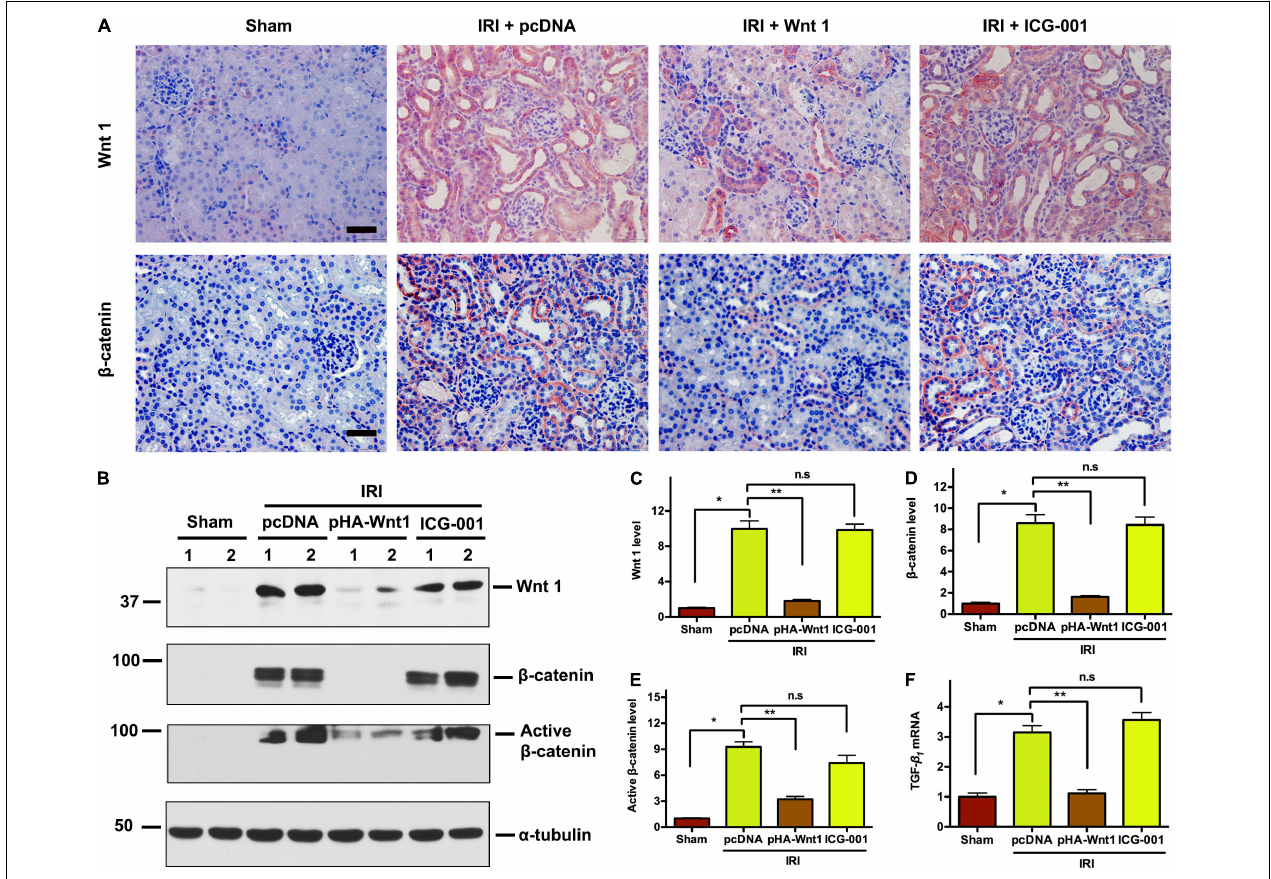
FIGURE 4 | In vivo expression of exogenous Wnt1 before IR down-regulates endogenous Wnt1 and β -catenin in kidneys of mice after AKI-CKD progression. (A) Representative micrographs show Wnt and β -catenin protein expression in different groups as indicated. Scale bar, 50 µ m. (B–E) Representative Western blot analyses of Wnt1, β -catenin, and active β -catenin protein levels in different groups as indicated. (F) mRNA expression of TGF- β in different groups as indicated. * P < 0.05; ** P < 0.01. n = 5.